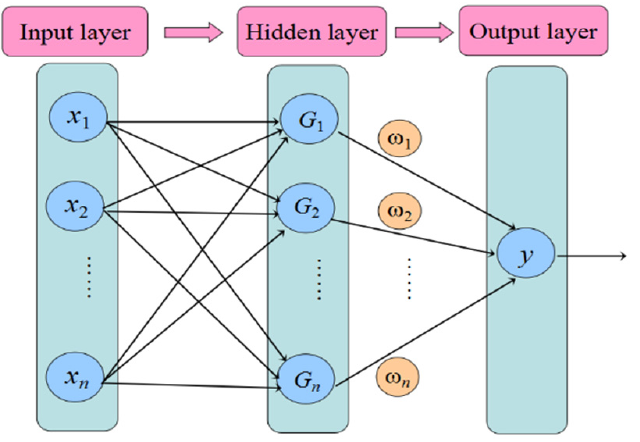
Figure 10. Schematic diagram of RBF-NNM.